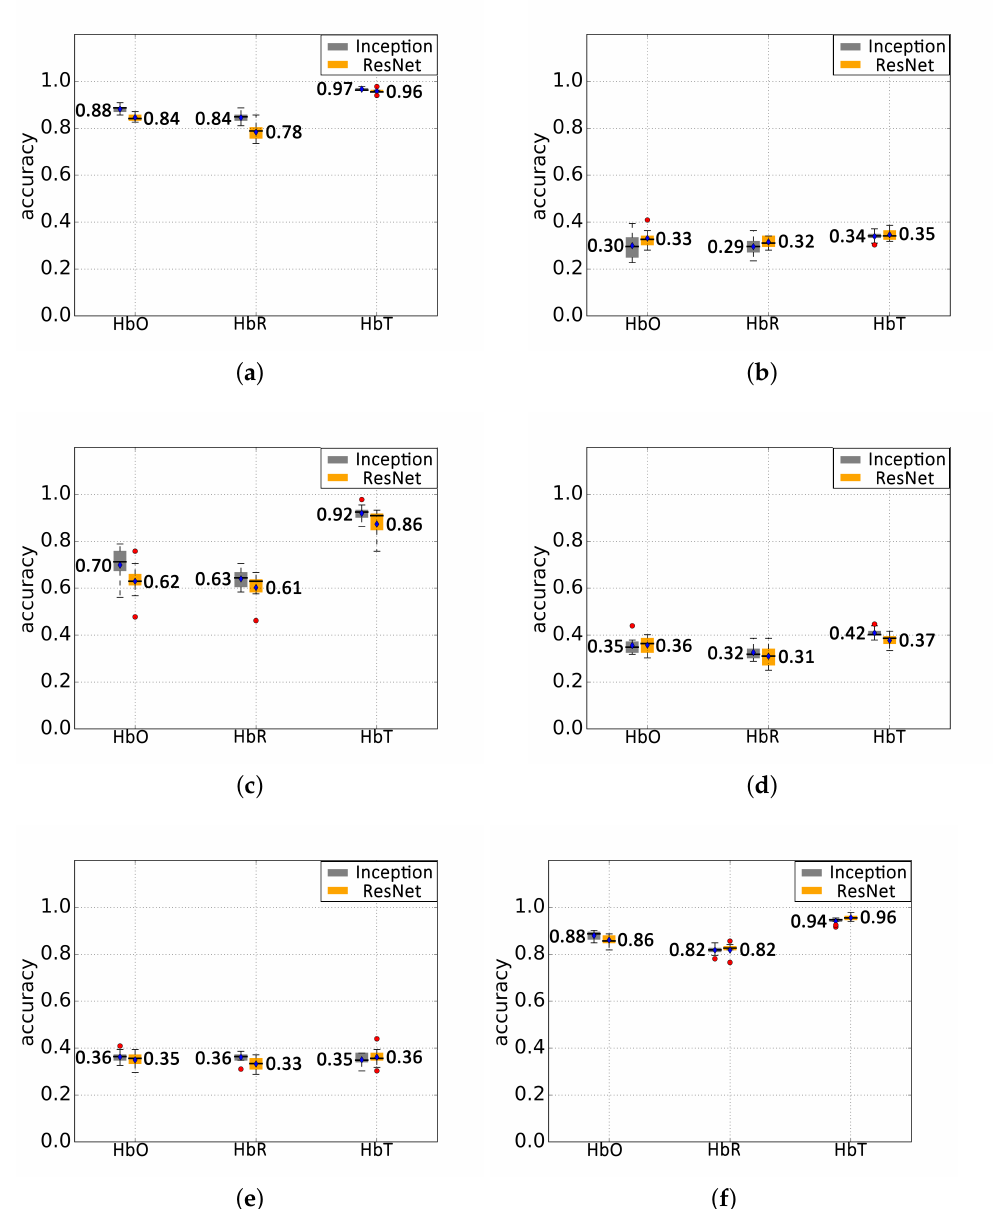
Figure 9. The accuracy box plot of the classification using HbO, HbR and HbT matrices. ( a ) The classification of raw data, ( b ) The classification of data after Z-normalization, ( c ) The classification of data after Max-min normalization, ( d ) The classification of data after FIR band-pass filter, ( e ) The classification of data after Butterworth band-pass filter, ( f ) The classification of data after baseline